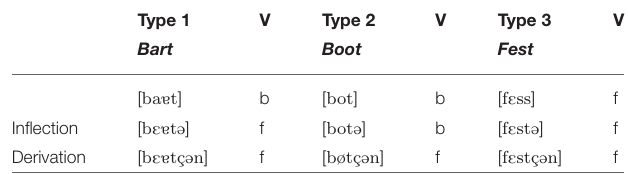
FIGURE 3 | Frame representation of the inflectional class of nouns such as [ hAnt ] “hand.” Uml(aut) indicates a fronted vowel, such that the pluaral is [ hEnd@ ].